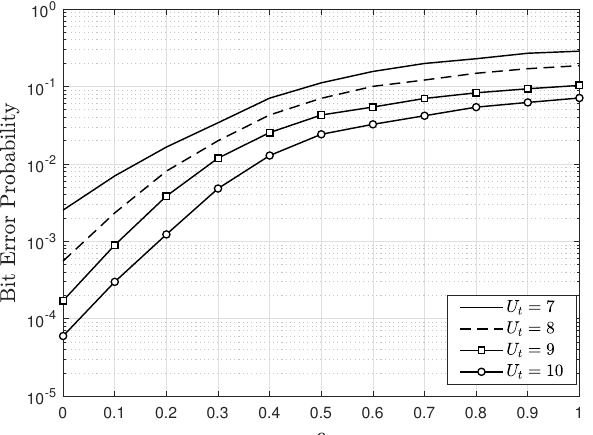
Figure 6. BER as a function of e , parameterized by U t , considering BPSK modulation, A = 6, U = 6, E b / N 0 = 10 dB and a channel with Rician factor K =